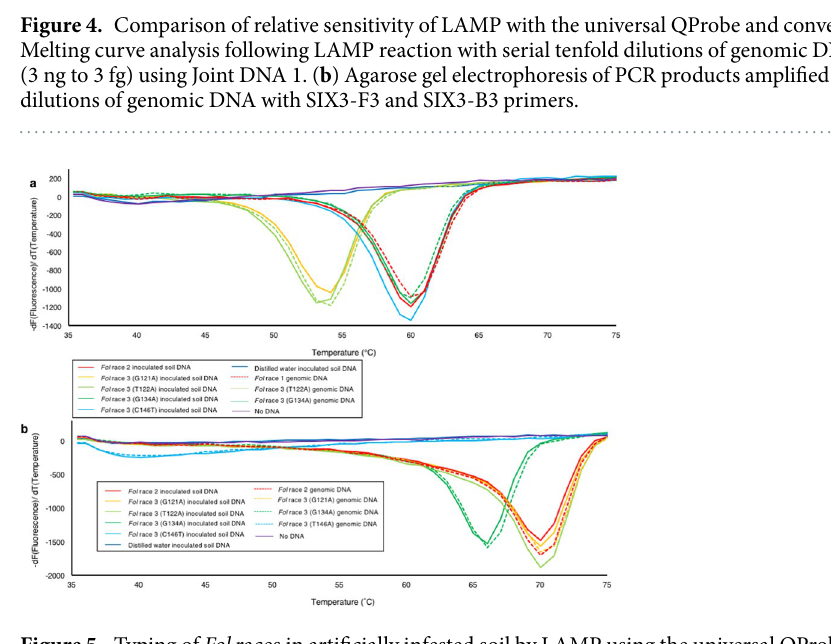
Figure 5. Typing of Fol races in artificially infested soil by LAMP using the universal QProbe with joint DNAs. Melting curve analysis of LAMP products using the QProbe combined with Joint DNA 1 ( a ) and Joint DNA 2 ( b ). Genomic DNAs of Fol or artificial infested soil DNAs by Fol were used as a template. Similar results were obtained in two independent